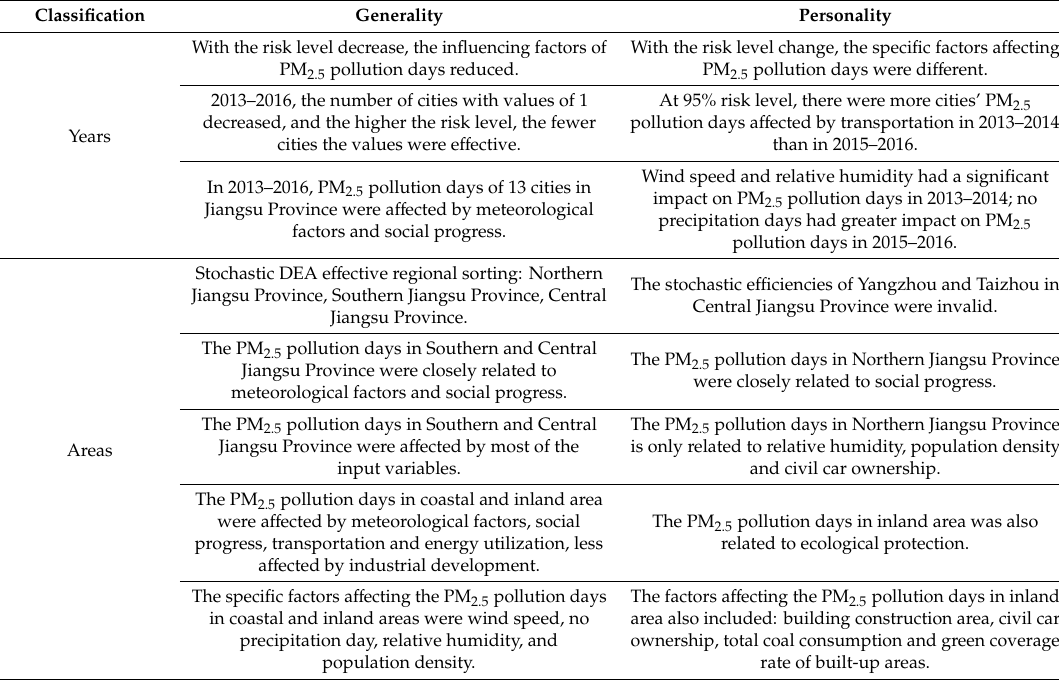
Table 6. Comparison of PM 2.5 influencing factors.